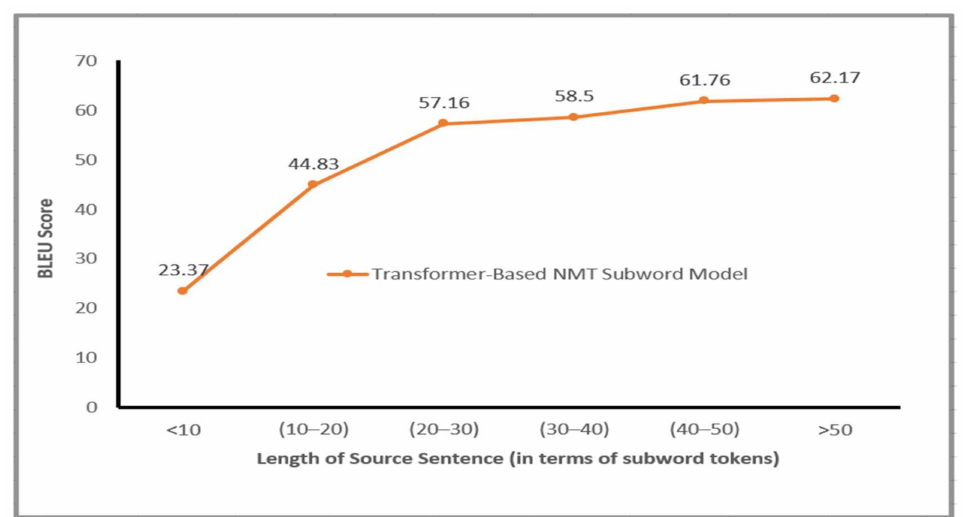
Figure 6. BLEU Score on MAG–MSA test dataset for the Transformer-NMT Subword model with respect to different source sentence length.